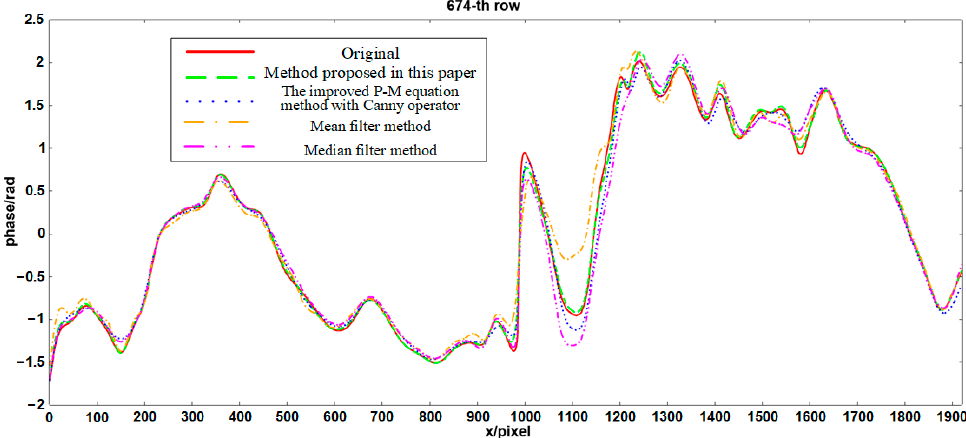
Figure 10. The cross-section curve at y = 674 of the phase maps shown in Figure 8a–d and the original phase map.